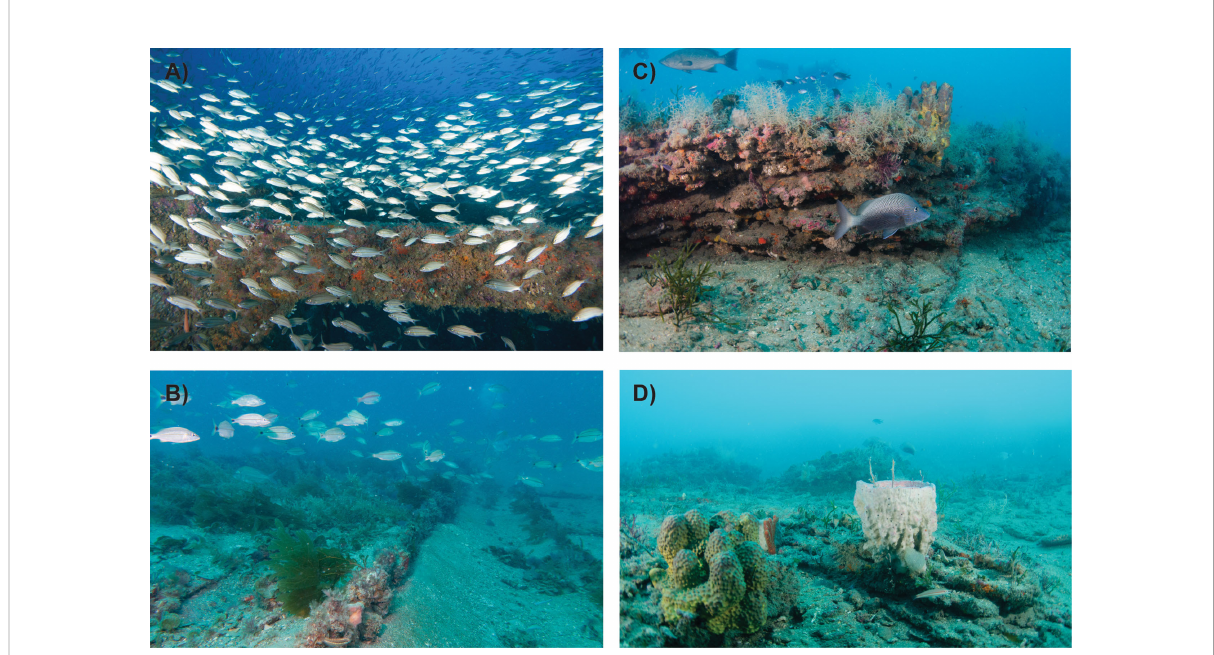
FIGURE 1 Underwater images of arti fi cial reefs (A, B) and natural reefs (C, D) on the southeast US continental shelf. (A) Arti fi cial reef created by a ship. (B) Arti fi cial reef formed from a train boxcar. (C) High-relief rocky reef. (D) Low-relief rocky reef. Photos by John McCord/Coastal Studies Institute (A) , Cory Ames/NCCOS (B) , Dave Sybert (C, D)